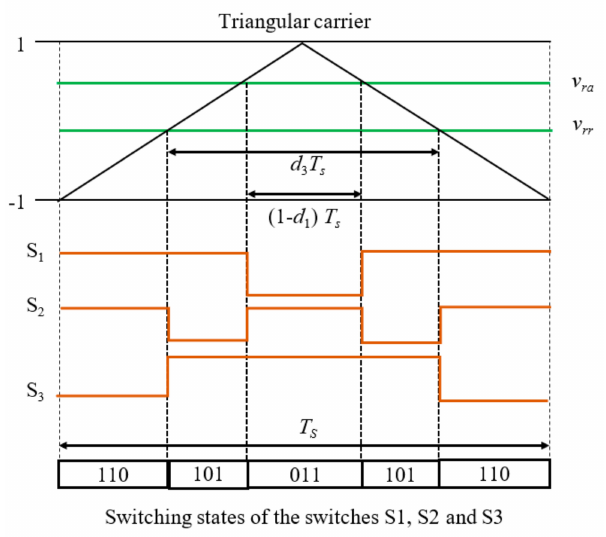
Figure 5. Carrier-based pulse width modulation (MCB-PWM) with double reference scheme for one branch of the TTI-MC. Where, T s is the period of the triangular carrier signal and d 3 and d 1 are the duty cycles of switches S3 and S1,